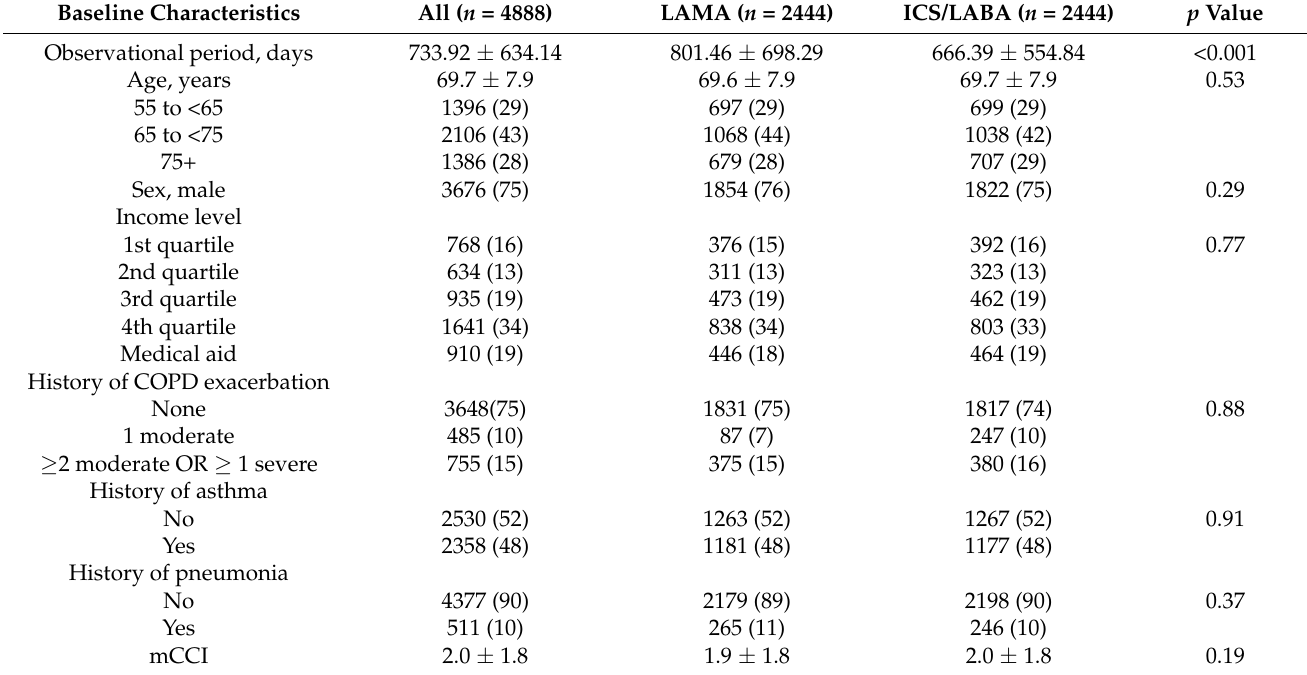
Table 1. Baseline characteristics of the propensity score-matched study population.